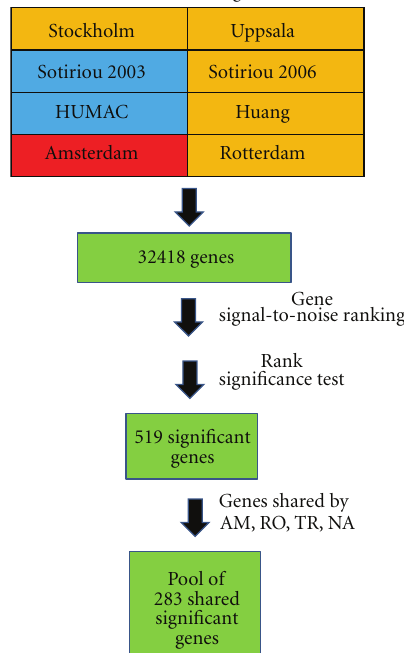
Figure 1: Feature selection. Eight breast cancer gene expression datasets (feature defining datasets), covering 32418 genes, were used to define a list of rank significant genes. Datasets using the A ff ymetrix platform, spotted oligonucleotides, and the Agilent platform are colored orange, blue, and red, respectively. These genes were first ranked within each of the eight datasets according to their signal-to-noise ratio, and their across dataset mean rank calculated. This mean rank was significance tested as described in Section 2, resulting in a list of 519 rank significant genes. These 519 genes were reduced to a pool of 283 genes shared by the two training sets (AM and RO) and the testing sets (TR and MA), used in the further